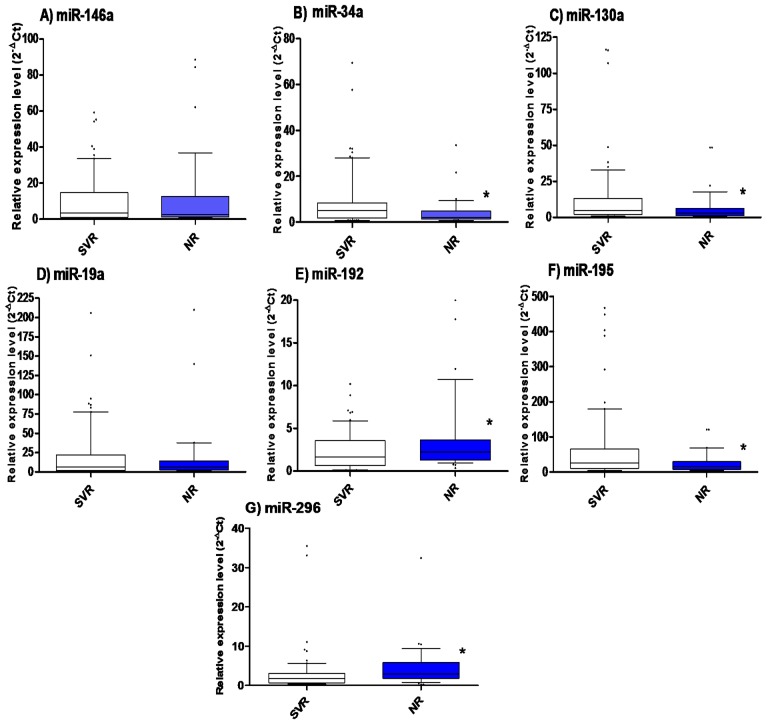
Serum miRNA expression levels in SVR and NR patients.The box represents the 25%-75% percentiles; the line inside the box represents the median and the upper and lower lines representing the 10%-90% percentiles of pretreatment expression levels of (a) miR-146a, P = 0.96, (b) miR-34a, P = 0.009, (c) miR-130a, P = 0.039, (d) miR-19a, P = 0.52, (e) miR-192, P = 0.035, (f) miR-195, P = 0.019, and (g) miR-296, P = 0.001 in SVR (n = 69) and NR patients (n = 37). Data were analyzed by Mann-Whitney U test. * indicates statistical significance (P<0.05).